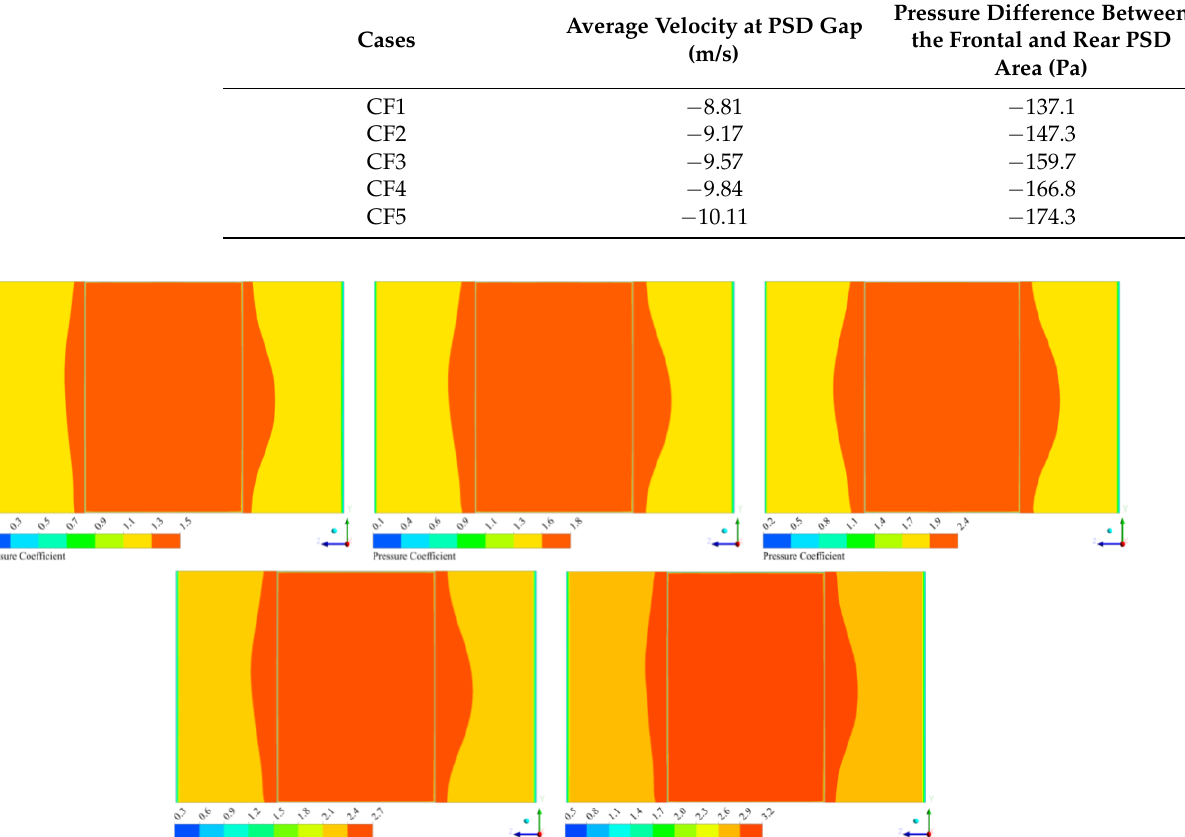
Figure 5. Pressure distributions on the PSD. Table 3. Full-scale modeling cases results summary.